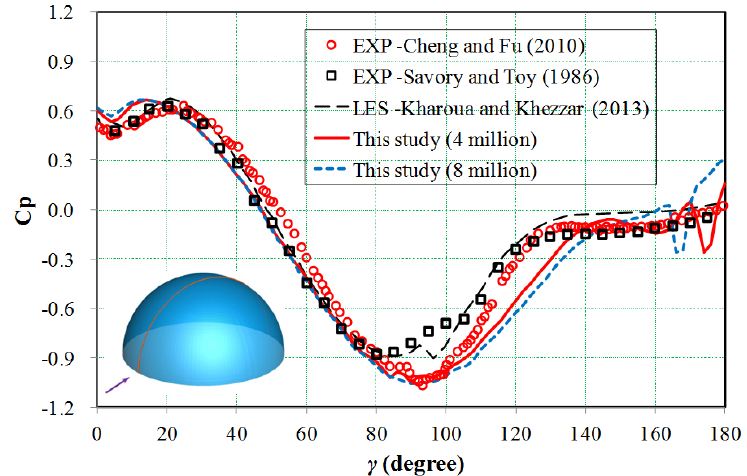
Figure 5. Comparisons of the mean pressure coefficient obtained in different studies along the centre meridian of a hemisphere in a turbulent boundary layer.